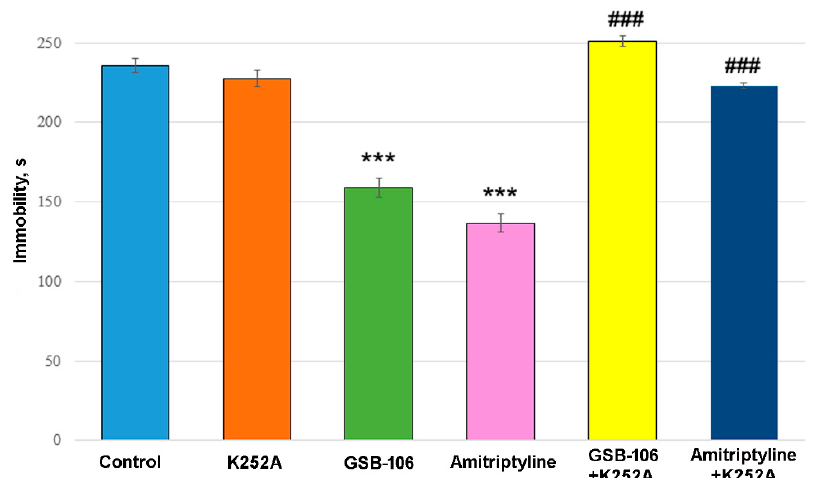
Figure 5. The antagonist of TrkB receptors K252A completely blocks the antidepressant-like activ- ity of the GSB-106 dipeptide and Amitriptyline in the forced swimming test in mice.Data are pre- the GSB-106 dipeptide and Amitriptyline in the forced swimming test in mice. Data are presented as sented as means and standard errors of the mean.*** p < 0.0001 statistical significance of differ- means and standard errors of the mean. *** p < 0.0001 statistical significance of differences compared ences compared to the “Control” group; ### р < 0.0001 statistical significance of differences com- to the “Control” group; ### p < 0.0001 statistical significance of differences compared to the “GSB-106” pared to the “GSB-106” or “Amitriptyline” group (two-way ANOVA with Tukey’s post hoc test). or “Amitriptyline” group (two-way ANOVA with Tukey’s post hoc Obtained results indicate that the antidepressant-like action of GSB-106 and Amitrip- tyline is attributed to the TrkB receptor activation.